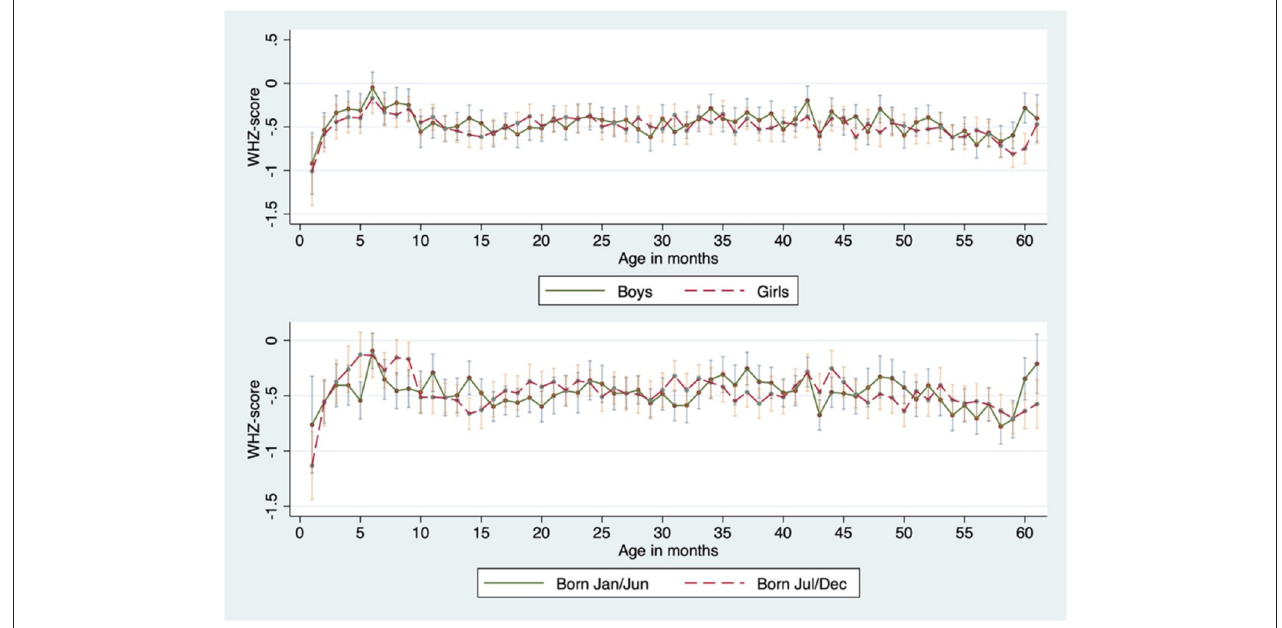
FIGURE 7 | Weight-for-height z-score by sex and by birth season in 2019. Source: Own elaboration based on Caritas Venezuela data. 95% confidence intervals.